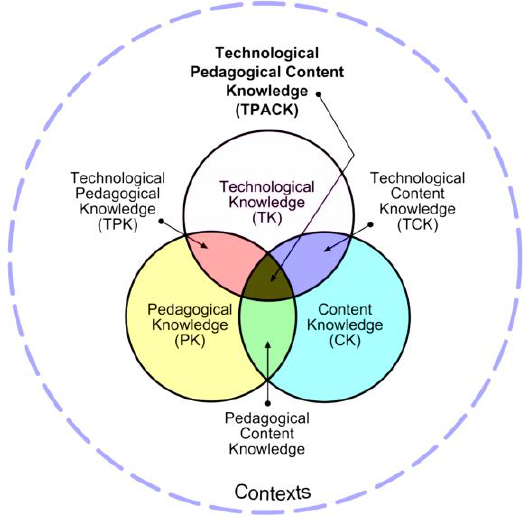
Figure 1. TPACK Framework (Source: